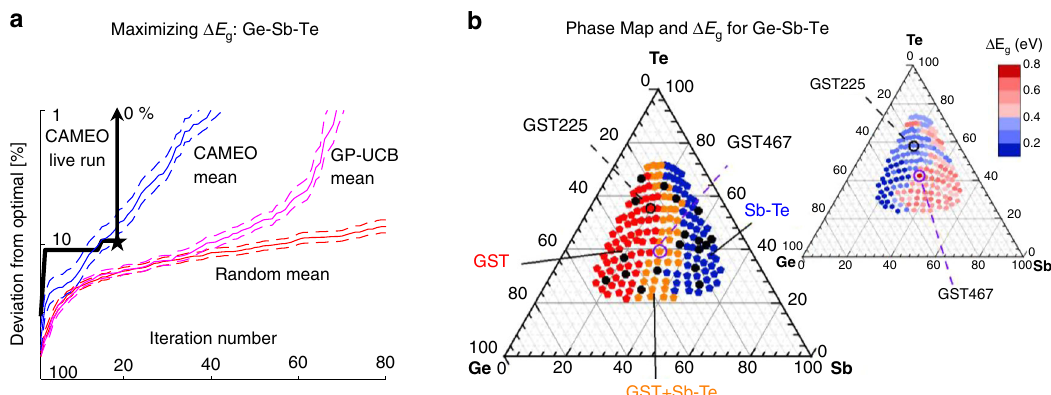
Fig. 3 Discovery of Ge 4 Sb 6 Te 7 (GST467). a Optimization of the Ge – Sb – Te system, with the objective of identifying the material with the largest Δ E g , bandgap difference between amorphous and crystalline states. Performance is shown for: the CAMEO live run (black) with GST467 discovered on iteration 19 (black star); for the mean and 95% con fi dence interval of 100 CAMEO runs computed post data collection (blue), 100 runs of Gaussian process-upper con fi dence bounds (GP-UBC, magenta), and random sampling (red). For the 100 runs, CAMEO gets within 1% of the optimal in the fi rst 20 runs 31% of the time compared to GP-UBC ’ s 10%. b Left: structural phase map for the crystalline Ge – Sb – Te composition spread. Complete phase map constructed after all the diffraction measurements (beyond the live CAMEO run described in a )) is shown. Structural phase regions are color-coded as single-phase FCC – Ge – Sb – Te (GST) structure region (red, GST), single-phase Sb – Te region (blue), and region where GST and Sb – Te phases co-exist (orange). The materials measured during the live CAMEO run are indicated in black. Right: Complete mapping of Δ E g following analysis of entire ellipsometry data (beyond the live CAMEO run). The discovered GST467 and GST225 are indicated in both